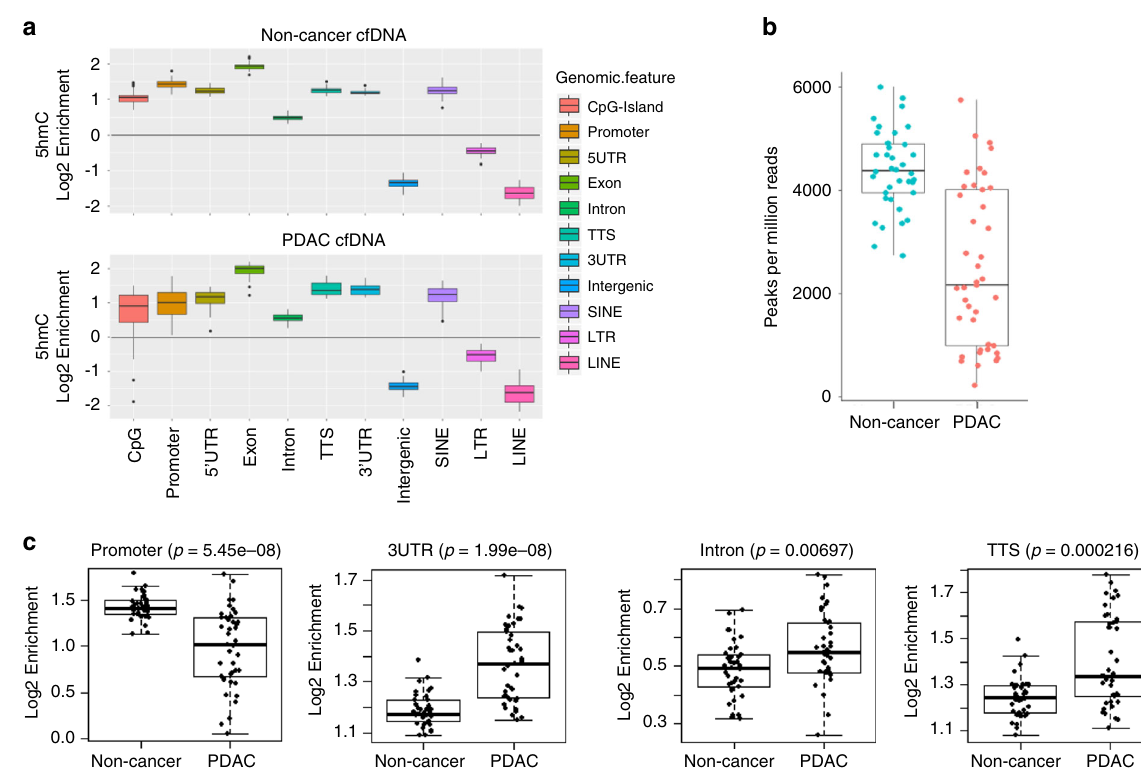
Fig. 1 Differential enrichment of 5hmC in genomic features in PDAC cfDNA compared with non-cancer cfDNA samples. a Boxplots showing 5hmC peak enrichment analysis ( y -axis = log2 enrichment) reveal that gene-based features and SINEs are enriched in 5hmC peaks in both PDAC ( n = 41) and non- cancer ( n = 38) cfDNA cohorts. Intergenic and LINEs are depleted of 5hmC peaks. b Number of 5hmC peaks detected per million reads in non-cancer (blue, n = 38) and PDAC (orange, n = 41) cohorts. Each dot depicts an individual patient sample. c Box plots depicting statistically signi fi cant changes of 5hmC peaks over promoters, 3 ′ UTR, Intron and TTS regions in PDAC cfDNA ( n = 41) compared to non-cancer cfDNA ( n = 38). Each dot represents an individual cfDNA sample. p -values are from two-sided Wilcoxon test. For all boxplots, center line represents median, bounds of box represent 25th and 75th percentiles and whiskers are Tukey